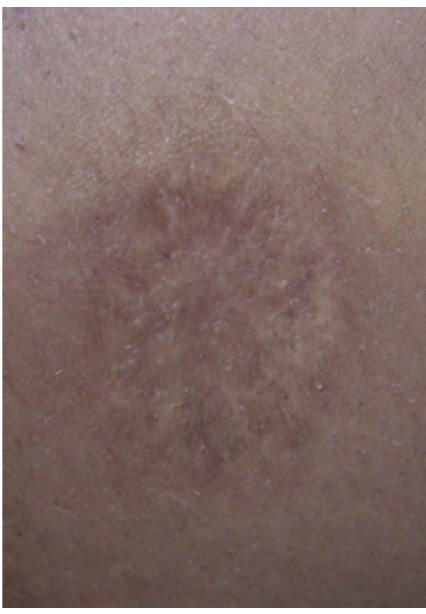
Figure 1: A well-delimited atrophic scar in the left thigh measuring 30 × 20mm.